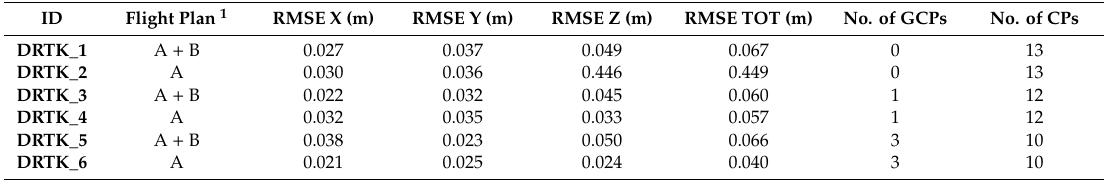
Table 14. DRTK approach. RMSE on CPs for configuration from NRTK_1 to NRTK_6.